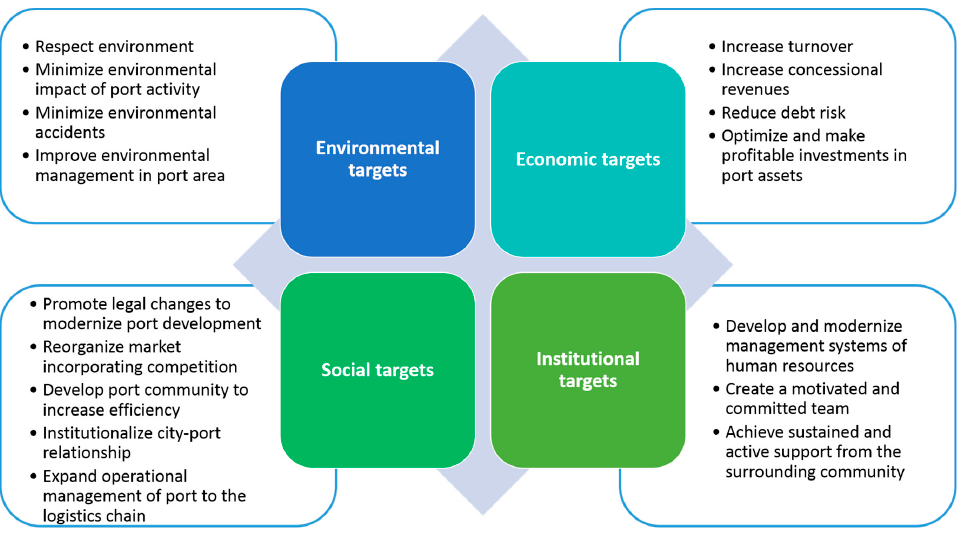
Figure 1. Sustainability dimensions: main objectives. Source: [18].